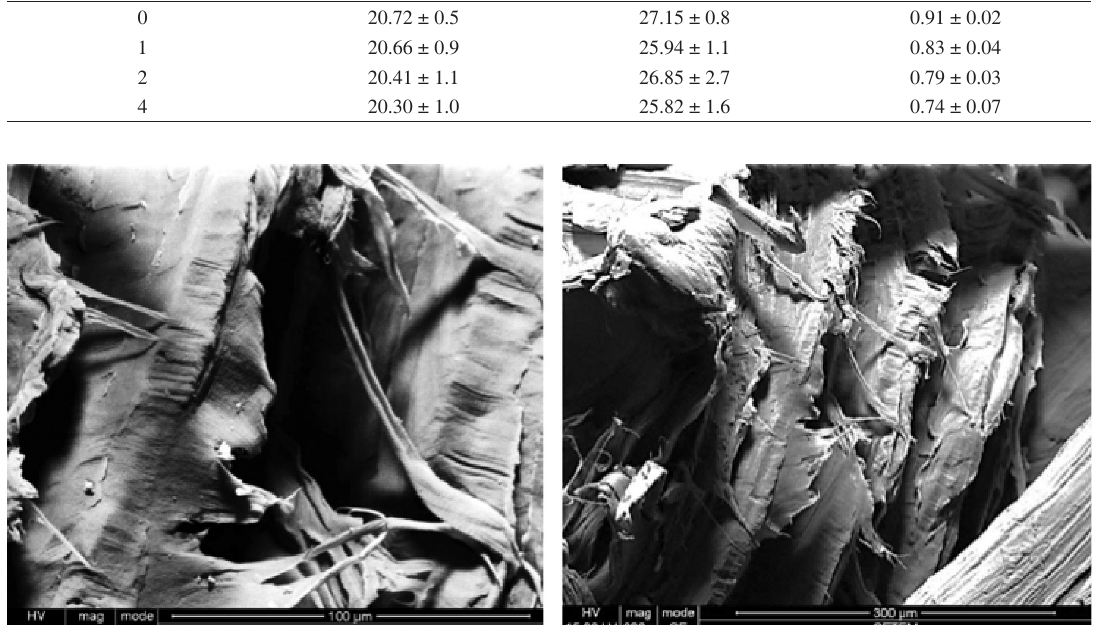
Table 1. Tensile strength of all Sisal/HDPE formulations. Fiber %